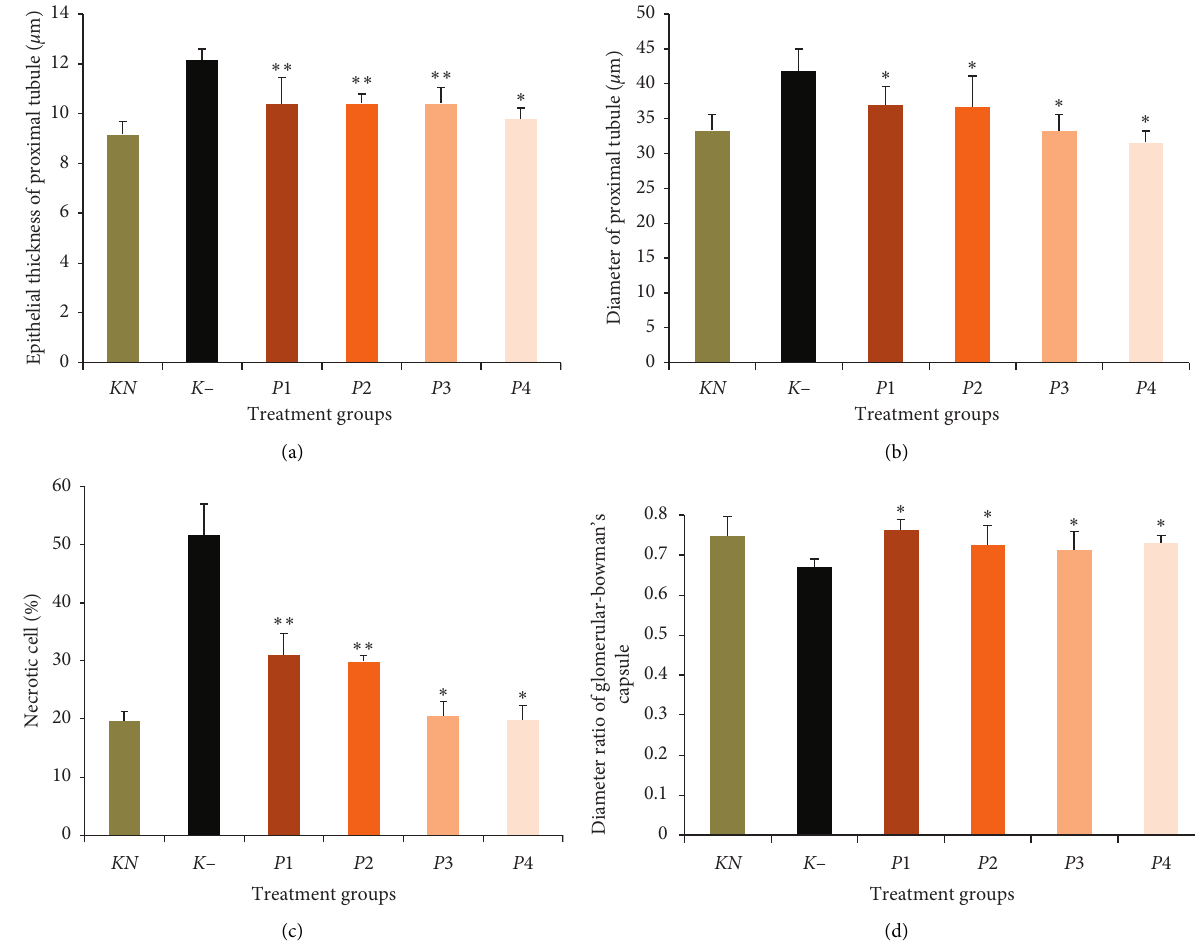
Figure 6: Effect of methanol extract of okra pods on kidney histology (thickness of epithelial proximal tubule, diameter of the proximal tubule, percentageofnecroticcells,anddiameterratioofglomerularBowman’scapsule)inleadacetate-treatedmice.Valuesareasexpressedasmean ± standard deviation ( n � 5). ∗ P < 0 . 05 shows significant differences in K − , ∗∗ P < 0 . 05 shows significant differences in KN and K − , confidence interval 95%. KN : normal control, K − : negative control. P 1, P 2, P 3, and P 4 were treated with 50, 100, 200, and 400mg/kg BW methanol extract of okra pods,